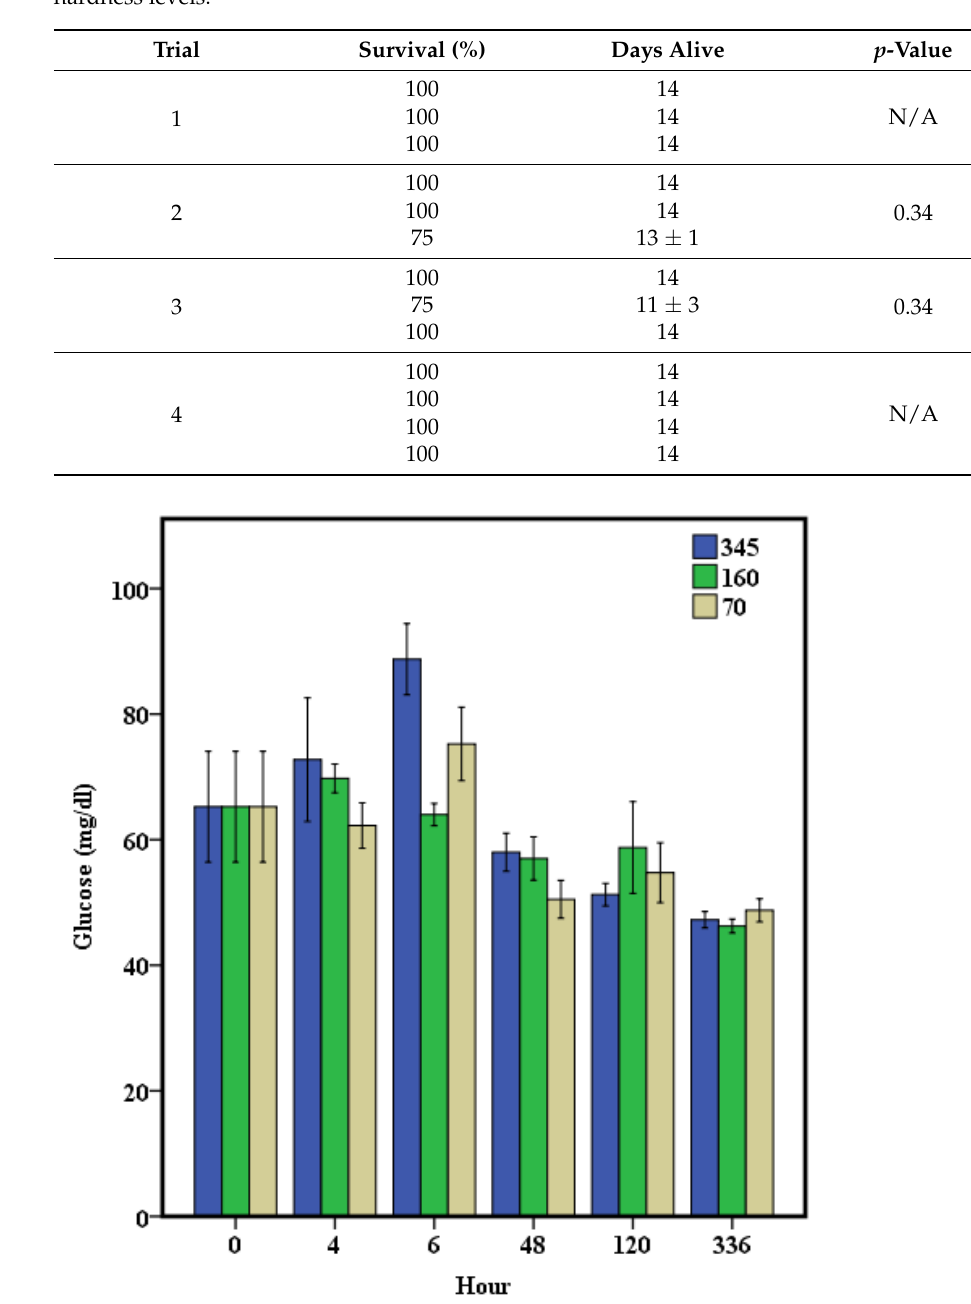
Figure 1. Trial 1 glucose levels ( ± SE) at the beginning (hour 0—before transfer, hardness of 345 mg/L) and 4, 6, 48, 120, and 336 hours after the start of the trial when rainbow trout Oncorhynchus mykiss ( n = 4 for each treatment at each timepoint) were directly transferred from 345 mg/L water hardness to experimental conditions without